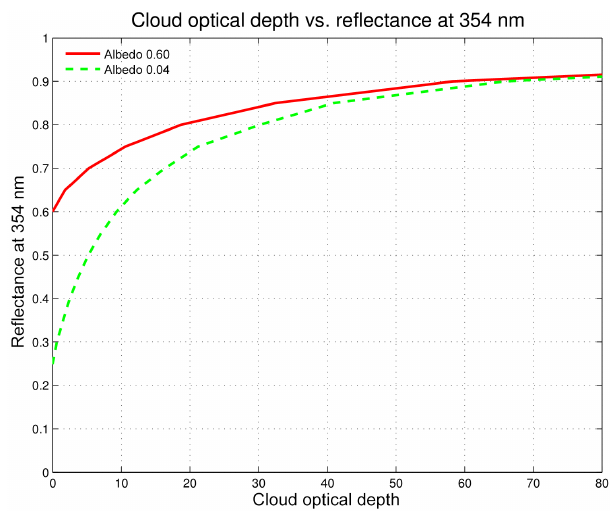
Figure 3. Cloud optical depth vs. the reflectance at 354nm accord- ing to the look-up table. For the relationship shown here, the surface pressure was p s = 1atm and the solar and viewing geometry was θ v = 40 ◦ , θ 0 = 45 ◦ , and φ r = 60 ◦